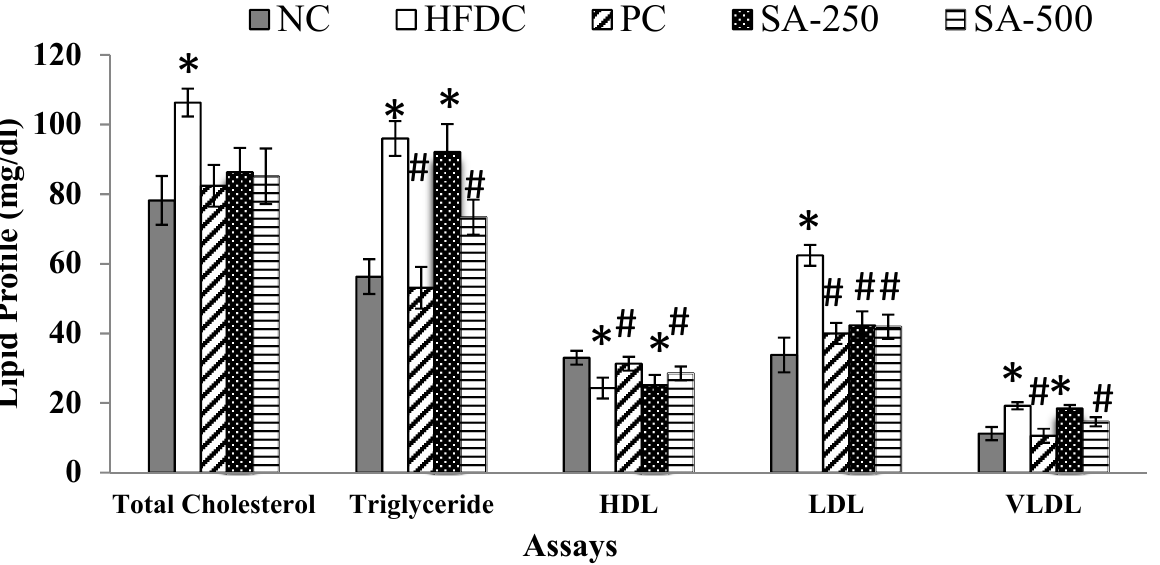
Figure 2. Effect of different treatments on the lipid metabolic profile on different rat groups. * p ≤ 0.05 difference compared to NC and # p ≤ 0.05 when compared to HFDC group.